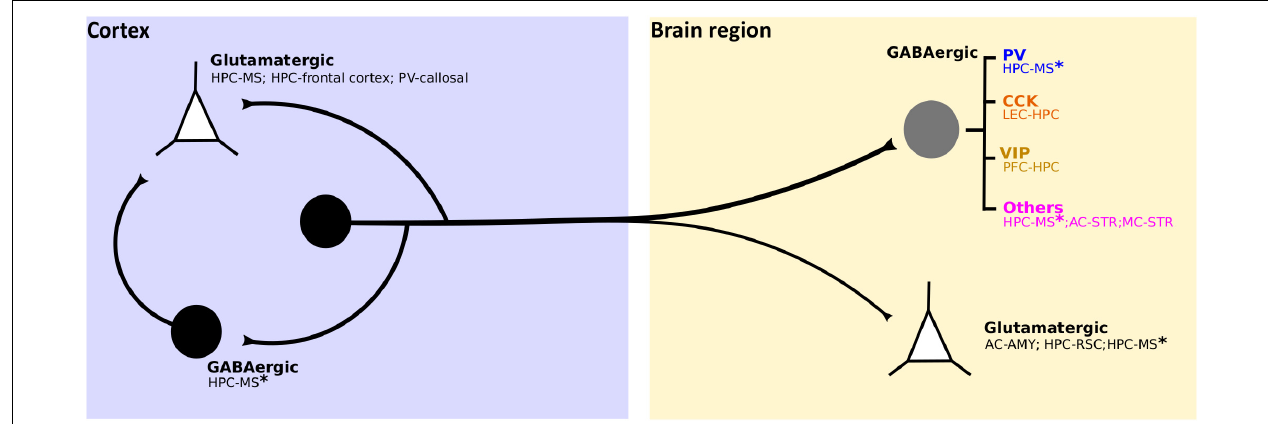
FIGURE 4 | Identified cellular targets of cortical LRGNs. Cortical LRGNs (from HPC or neocortex) project to distal subcortical or cortical areas (yellow box), establishing synapses with different cell subtypes. Some LRGNs (black circle) target excitatory neurons (white triangles) mediating direct long-range inhibition, but the main targets are different subtypes of GABAergic neurons (gray circle). If the postsynaptic targets are PV-INs or Fast Spiking (blue), the final effect of LRGN activity is to increase the output of principal cells in the distal region. By inhibiting dendrite-targeting CCK-INs (orange), LRGNs would potentiate synaptic gain and information flow. Recent non-peer review work reveals potential VIP + targets (dark yellow), which suggests that LRGNs may also act by reducing disinhibition. Moreover, corticofugal LRGNs can target other GABAergic cells (MSNs and diverse INs) and cholinergic INs (pink), whose final impact on circuit function may be multiplicative and affect neuromodulation. Interestingly, some LRGNs like HPC-MS* have diverse targets, thus likely have multiplexed functions. Additionally, LRGNs can locally target inhibitory or excitatory neurons, as HPC-MS LRGNs in DG and callosal PV-LRGNs in the AC, respectively; presumably coordinating both local and distal